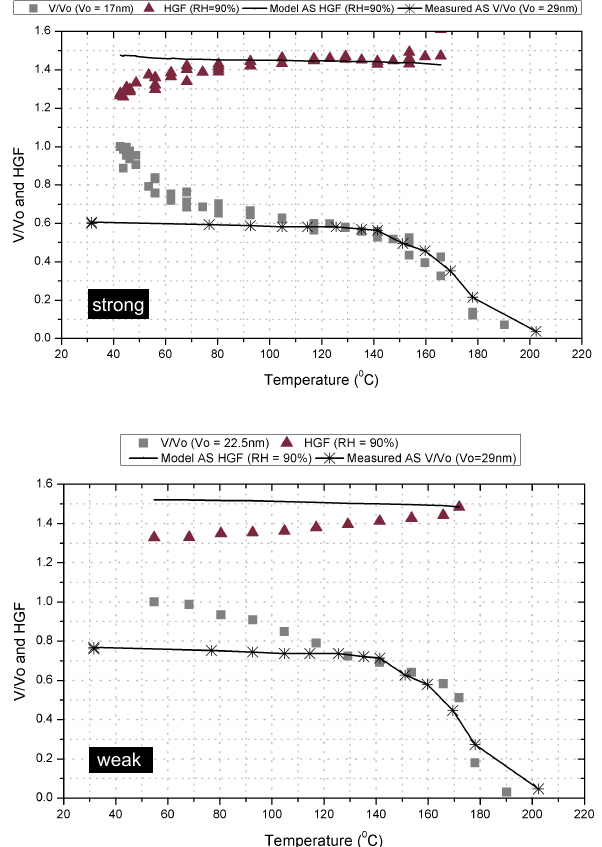
Fig. 9. VHTDMA scans completed during a strong (top) and weak (bottom) nucleation event. V/Vo is volume fraction remaining and HGF (RH=90%) is the growth factor at 90% RH for the atmo- spheric particles. The solid black lines indicate measured volatil- ity curve of ammonium sulphate (AS) particles normalised to the apparent volume fraction of the more hygroscopic component and theoretical, dry size dependent ammonium sulphate growth